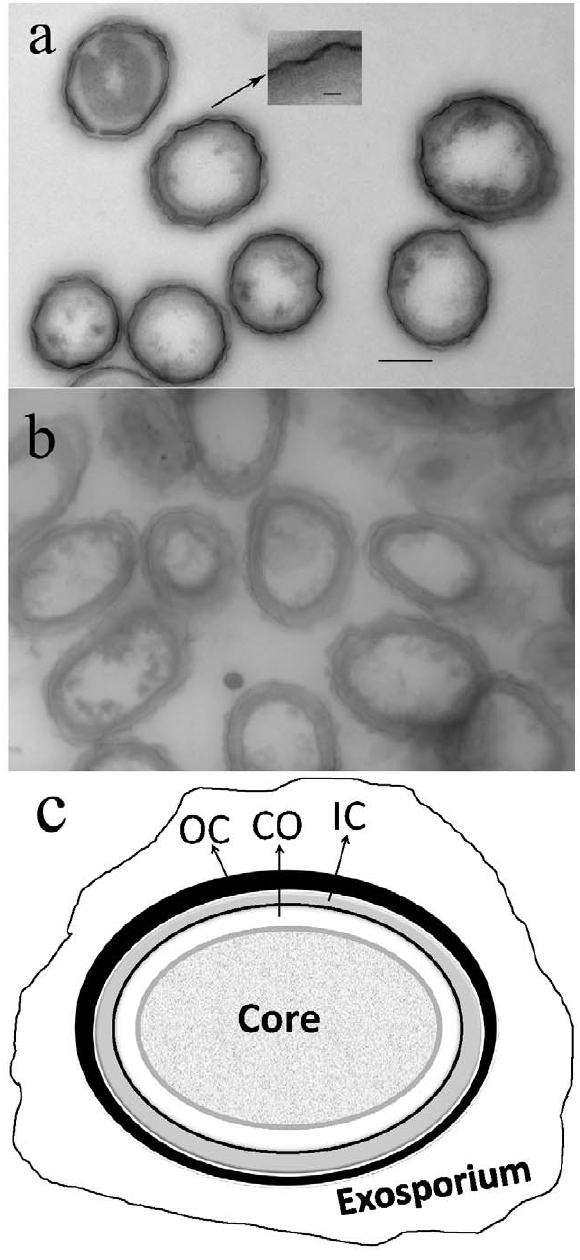
Figure 1. Topologically specific electron-dense layer in F-spores. Electron micrographs of unstained ultrathin (60 nm) cryosections. ( a ) F- spores from B. megaterium constructed with diacetyl-2,4,5,7-tetraiodo- fluorescein, an electron-dense fluorogenic probe. A conspicuous dark layer of about 14-nm thickness indicates binding of the high electron density probe to topologically specific coat proteins.* ( b ) Normal spores. ( c ) Line drawing representing a spore cross section: OC, outer coat; IC, inner coat; CO: cortex. Scale bars: 500 nm ( a–b ) and 40 nm ( a Inset ).